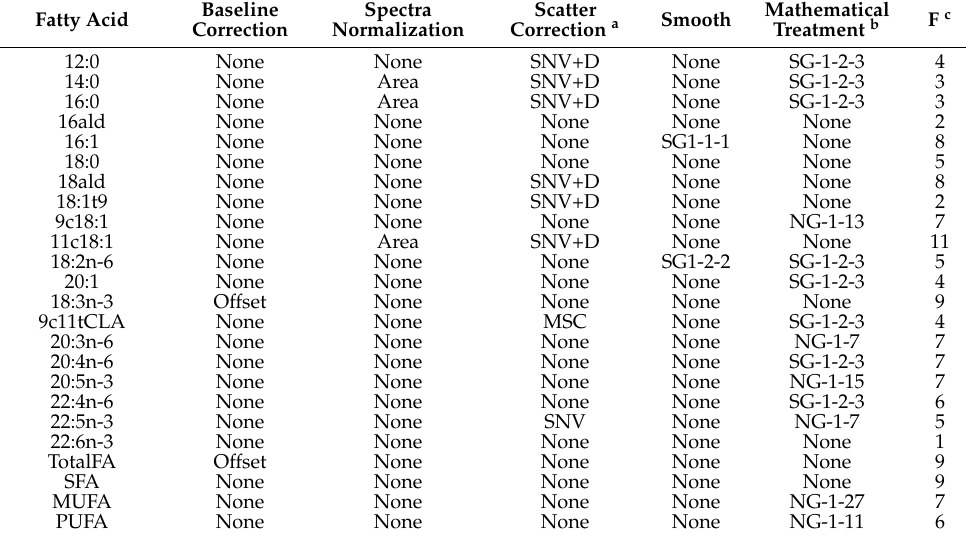
Table 4. Spectral treatments and factors included in the prediction models of total fatty acids of beef. Fatty